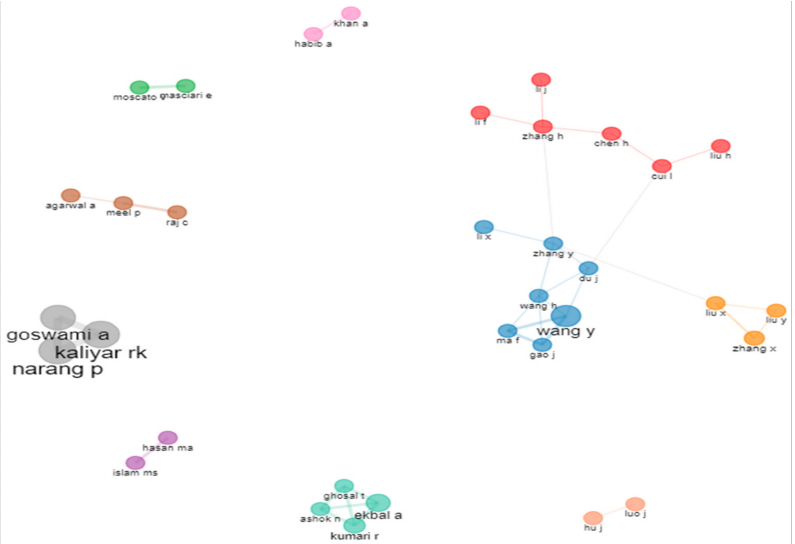
Figure 23. Network of co-authorship relationships among authors of publications.